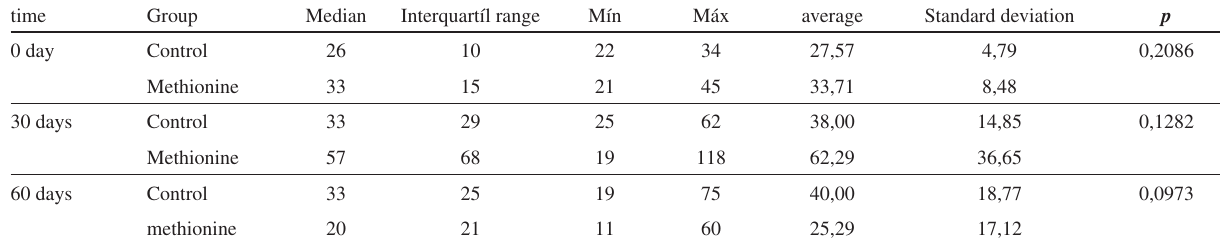
Table 4 - Plasma triglyceride levels (mg/dl)